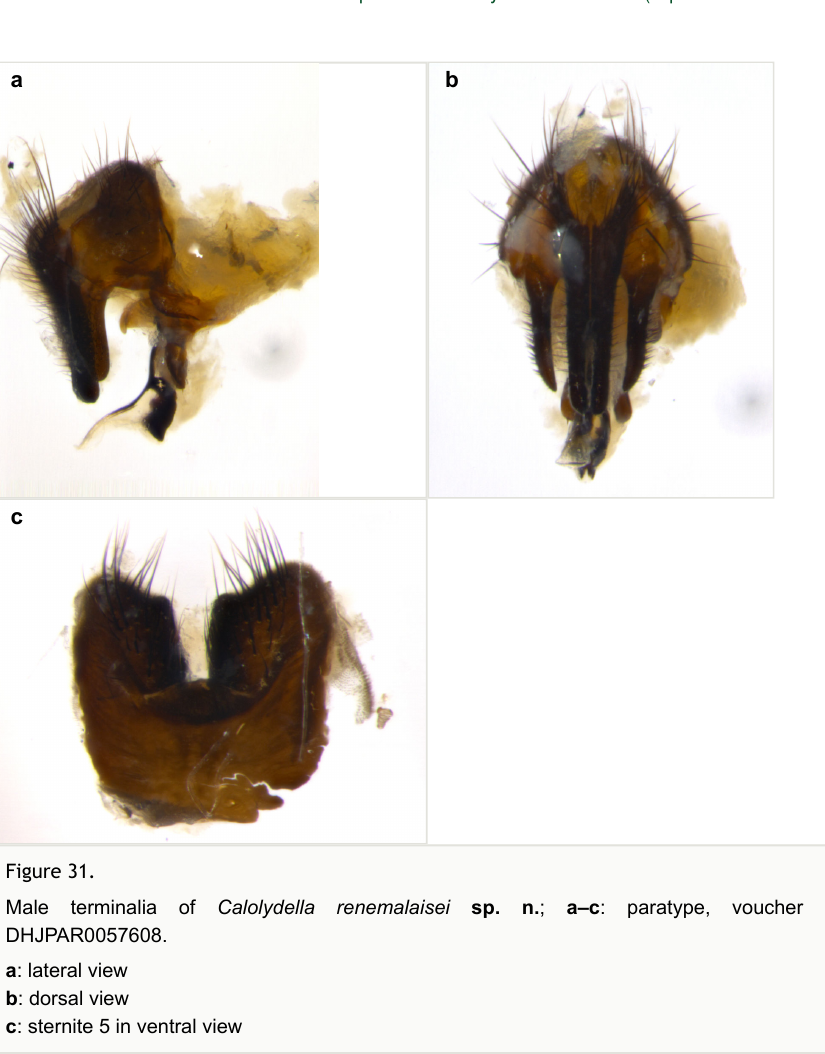
Female : not known at this time. Diagnosis